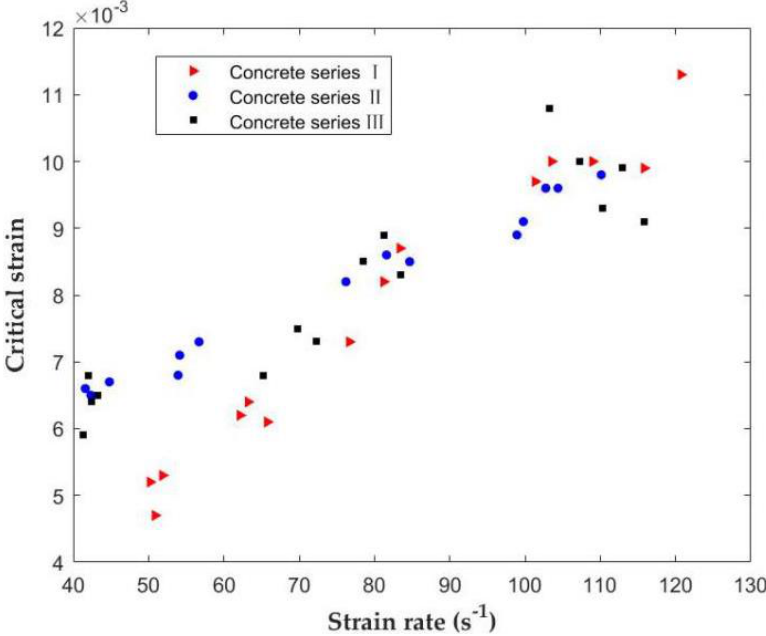
Table 8. The estimated results for different concrete in Equation (8).